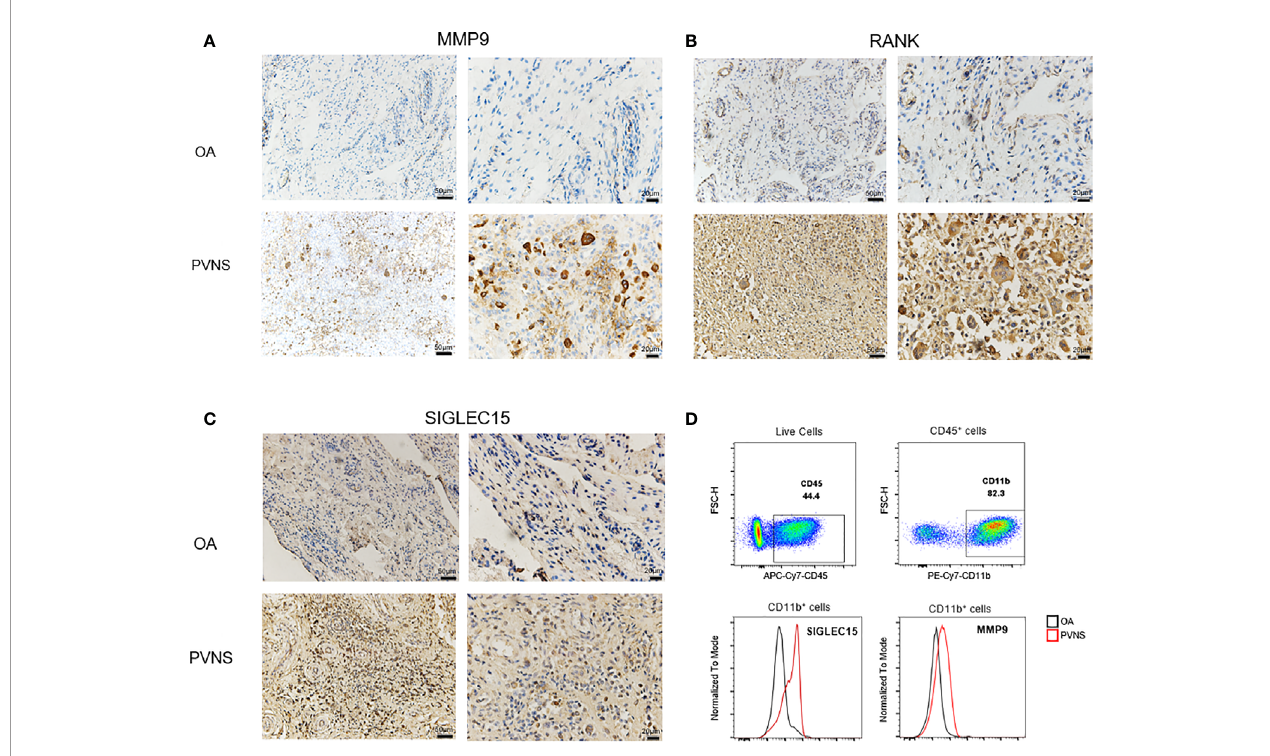
FIGURE 7 | Increased MMP9, SIGLEC 15, and RANK in PVNS patients MMP9 (A) , SIGLEC 15 (B) , and RANK (C) expression were detected by immunohistochemical test in synovium of PVNS and OA. Label is 50 m m or 20 m m. (D) SIGLEC 15 and MMP9 expression in surface of myeloid cell (CD45 + CD11b + ) were detected by fl ow